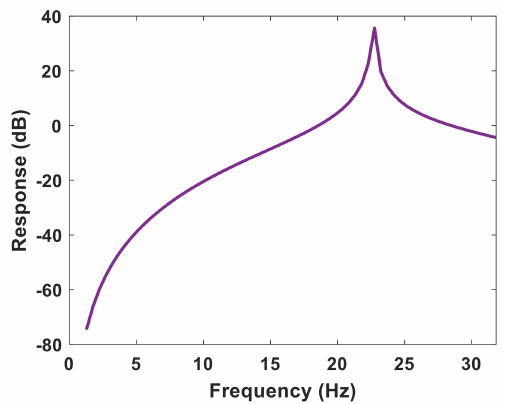
Figure 3. Simulated frequency response of a simply supported beam.